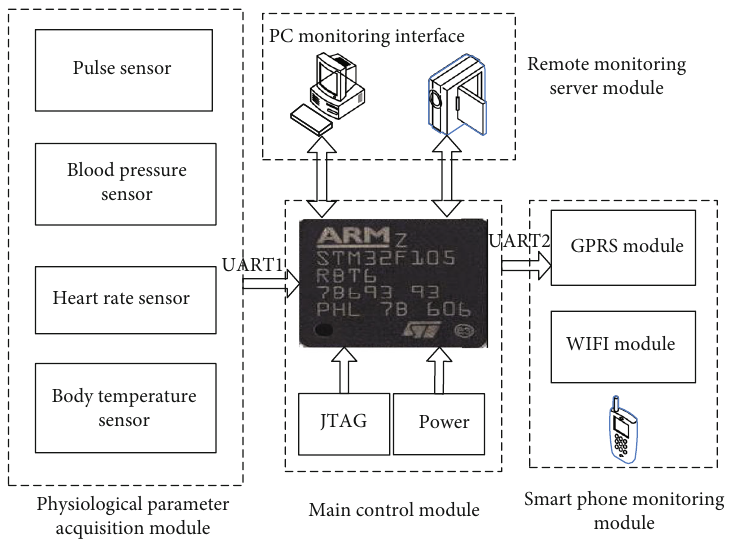
Figure 1: Overall architecture diagram of the system.